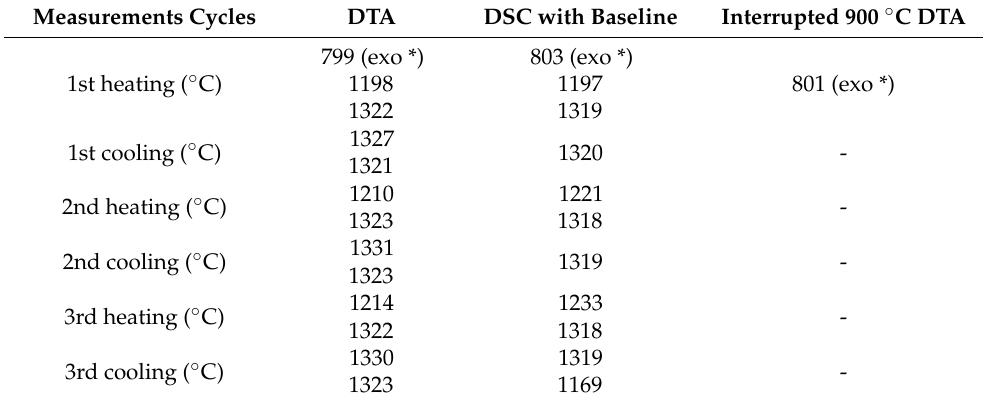
Figure 1. Pseudo phase diagram of (Co, Cr, Fe, Ni)–Mo versus mole fraction of Mo (i.e., Mo 0.85 ) showing co-existence of predicted phases in terms of increased Mo content. Table 3. Detected temperatures ( ◦ C) of thermal effects of the studied samples CoCrFeMo 0.85 Ni